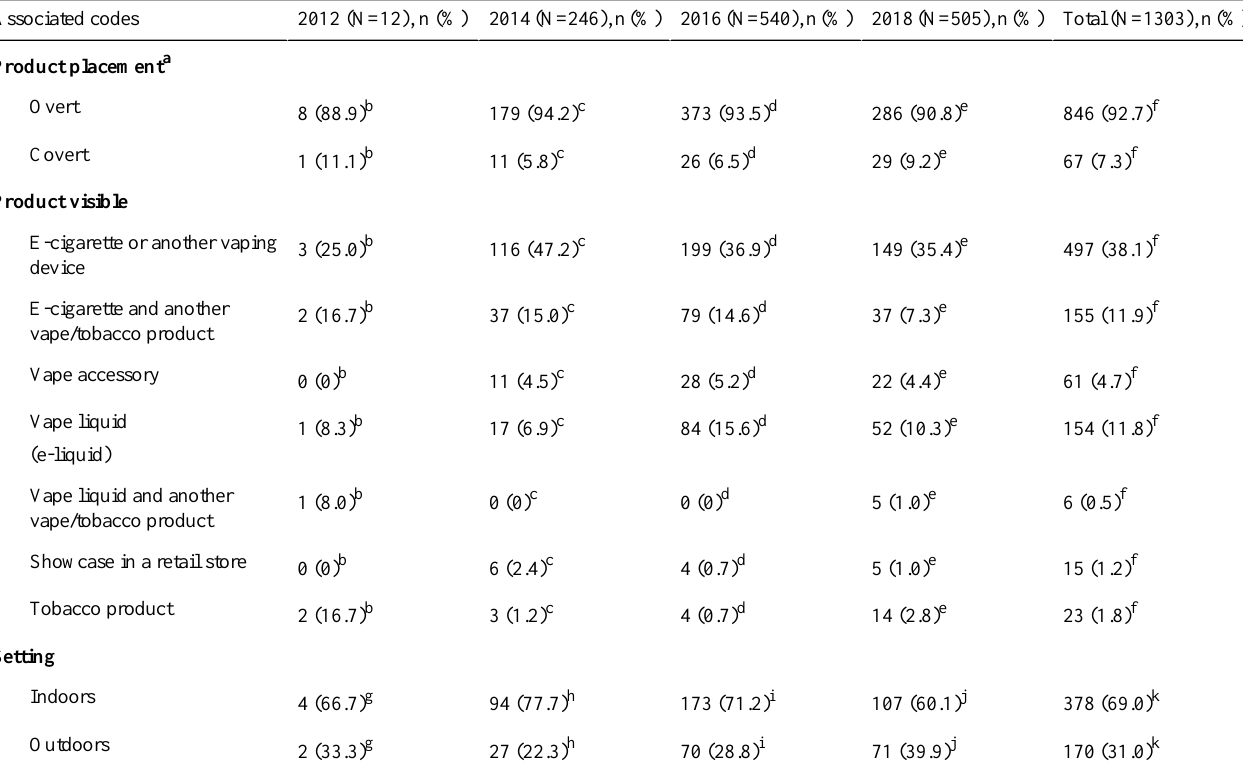
Table 3. Frequency statistics for each year corpus and the total sample within the “vape and tobacco products”